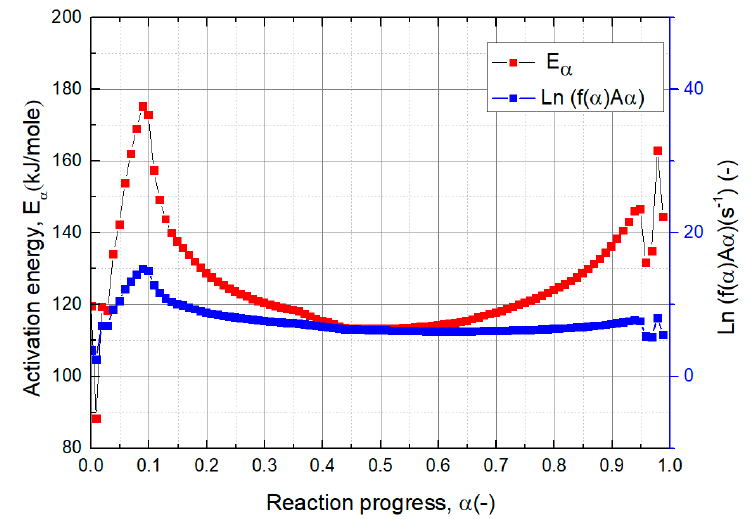
Figure 7. Activation energy and modified reaction constant ( A α f( α ) ) of reaction step 3 denoted in Figure 5b as a function of reaction progress α .